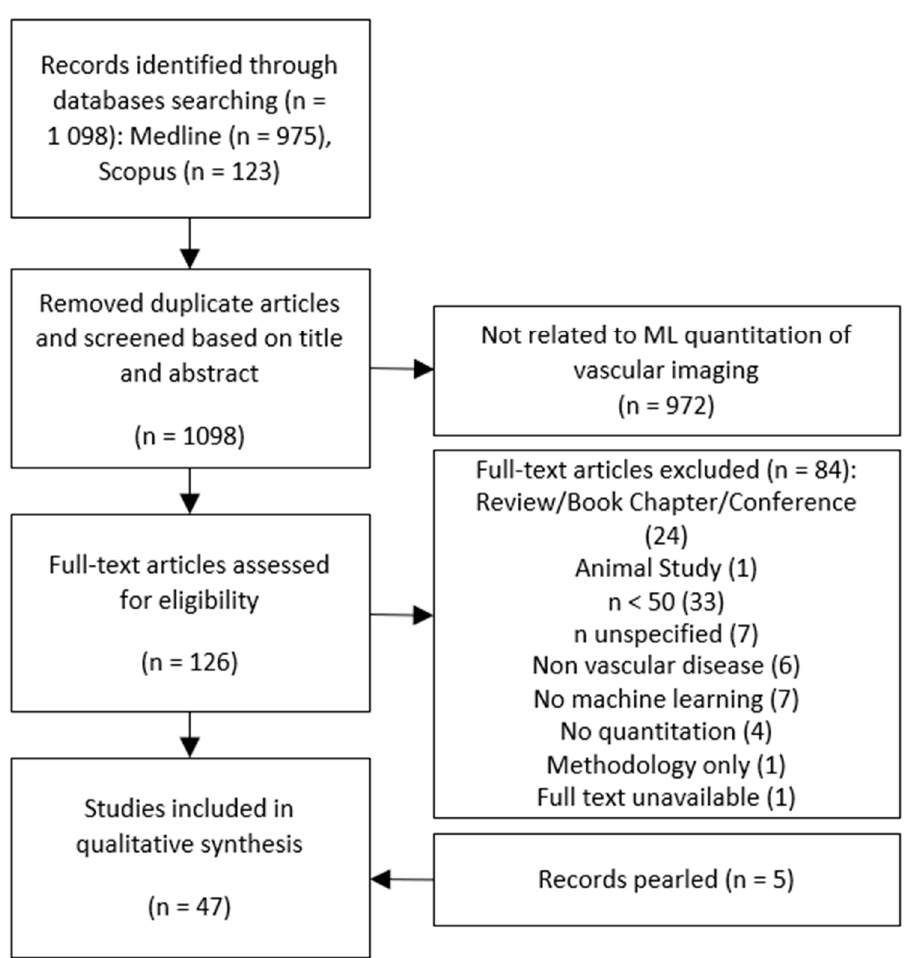
Figure 1. PRISMA (Preferred Reporting Items for Systematic Reviews and Meta-Analyses) flow diagram of literature selection process.